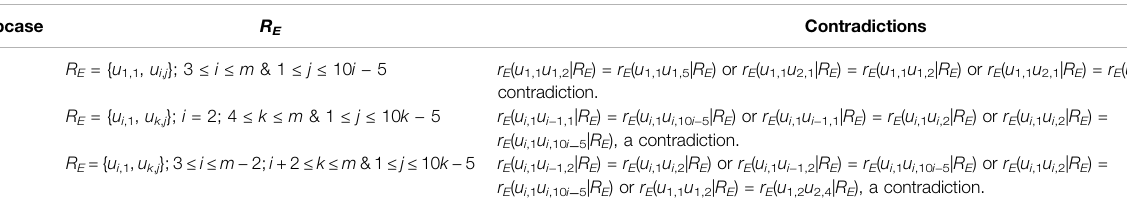
TABLE 3 | Case 3: When the vertices u l,1 and u z,j lie on two distinct cycles that are not neighboring. Subcase R E